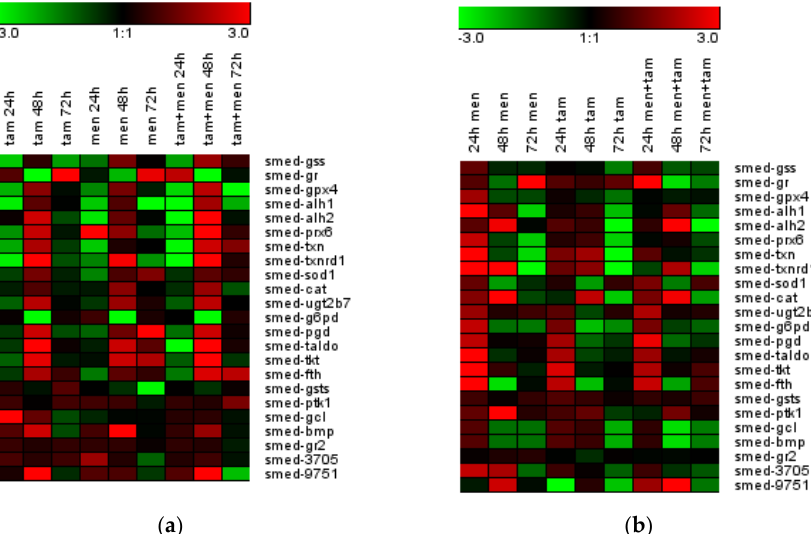
Figure 7. Tameron’s effect on expression of oxidative stress response genes in intact ( a ) and regenerating ( b ) planarians. The figure shows heatmaps reflecting changes in expression of a test panel of neoblast marker genes in planarians after menadione-induced oxidative stress and/or treatment with Tameron compared to untreated animals. The scale of intensity of the standardized expression values extends from − 3 (green: low expression) to +3 (red: high expression). The 1:1 intensity value (black) represents the non-treated control. A non-treated control group was taken as a control. Menadione (Men) was used at working concentration of 10 − 6 M, Tameron (Tam)—10 − 4 M. The measurements were made on the 24th, 48th, and 72nd h after